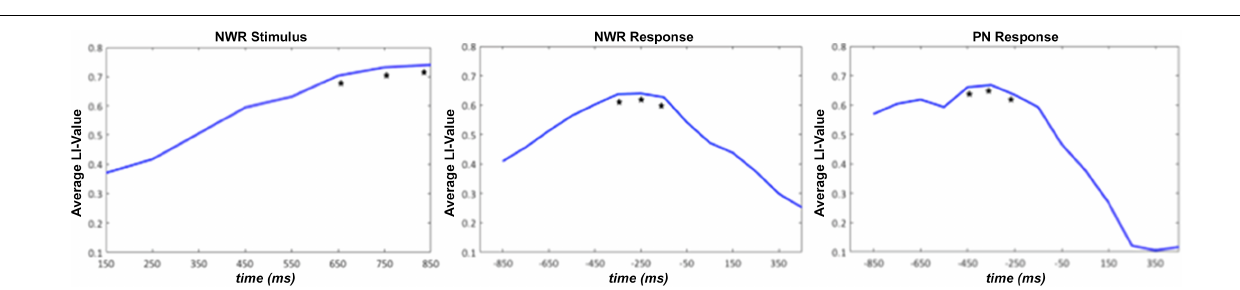
FIGURE 4 | Average laterality index (LI) value for the strong left group for stimulus-locked NWR (time 0 ms = auditory stimulus presentation) and response-locked NWR and PN (time 0 ms = visual stimulus presentation). The three consecutive time points with the highest correlation with VG LI scores are indicated with a